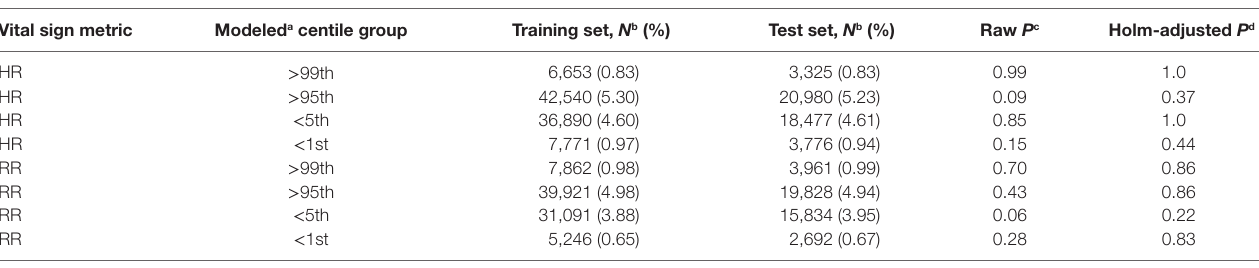
TaBle 3 | Validation of vital sign centile modeling